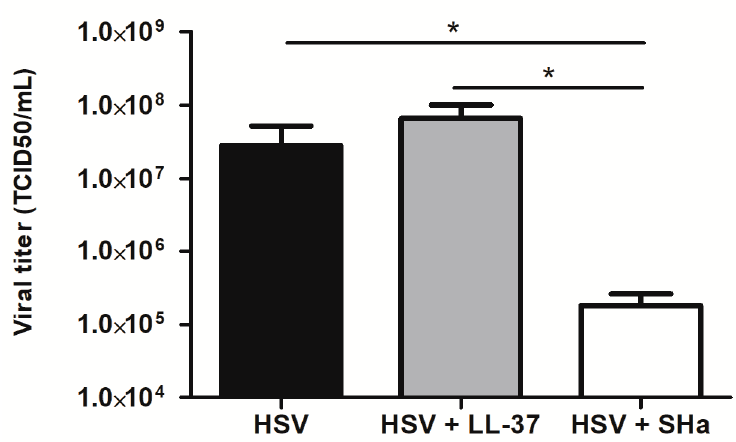
Figure 4. Evaluation of virucidal properties of LL-37 and SHa on HSV-1. HSV-1 suspension was pre-incubated in absence or presence of LL-37 (2.5 µM) and SHa (10 µM) for 1 h at 37 °C before titration by end-point dilution assay on Vero cells. Viral titers are expressed in TCID 50 /mL. Data are represented as mean + SEM of three independent experiments. * p < 0.05.